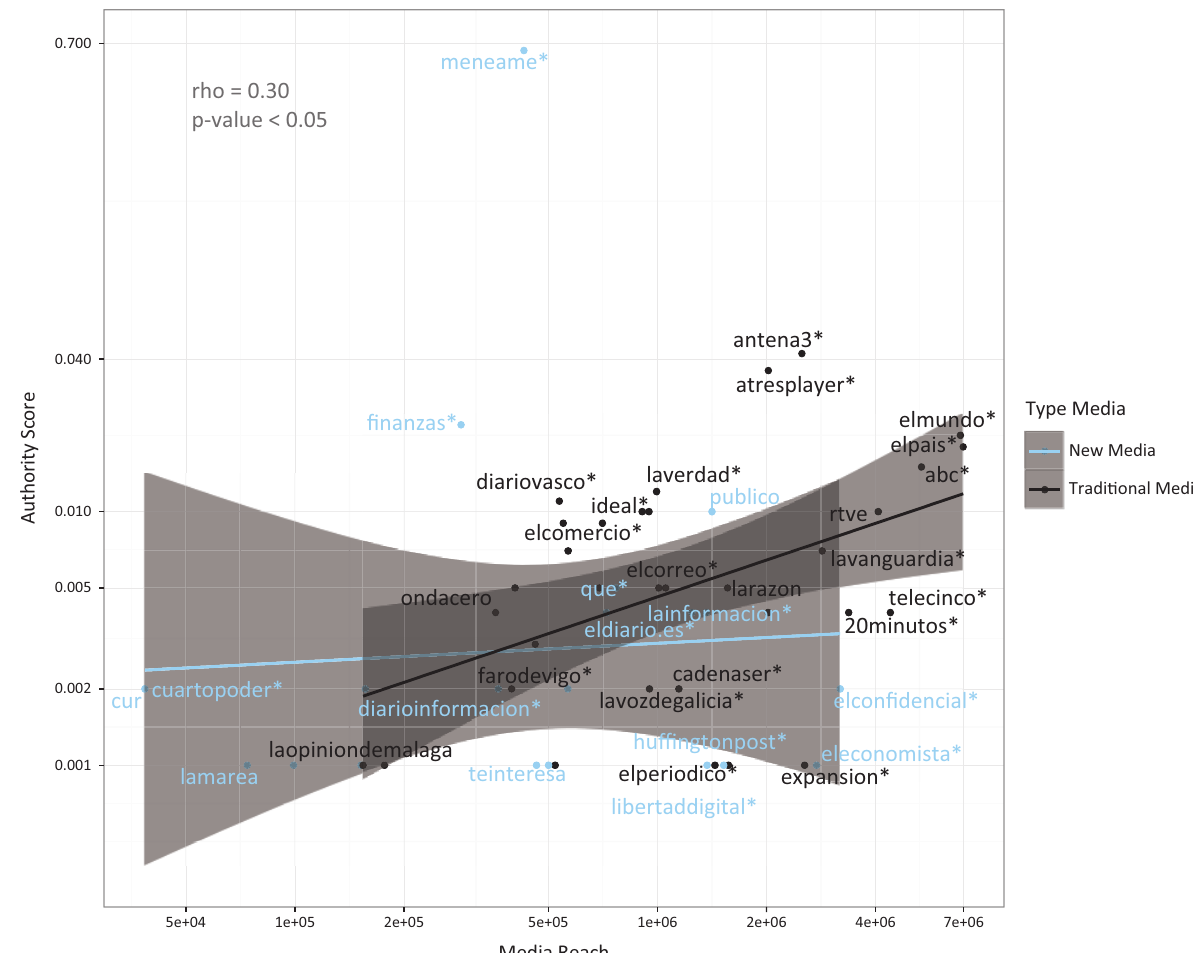
Figure 1. Association between authority scores in the news network and audience reach. Note: * significant